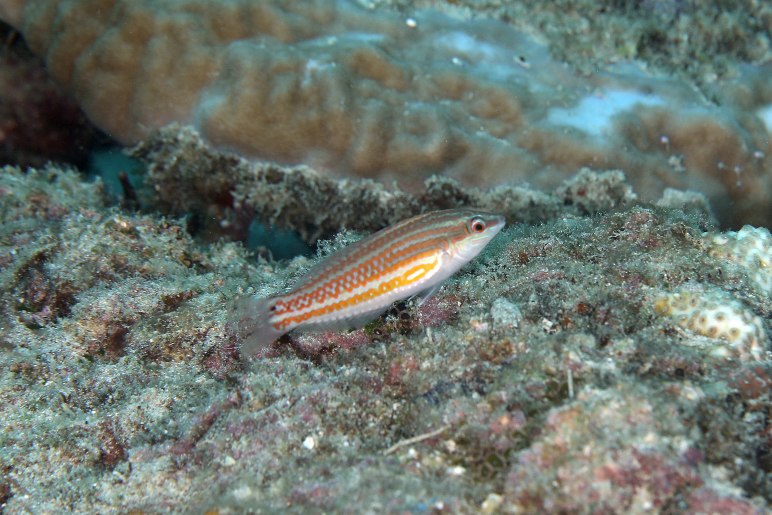
Halichoeres
erdmanni (female)